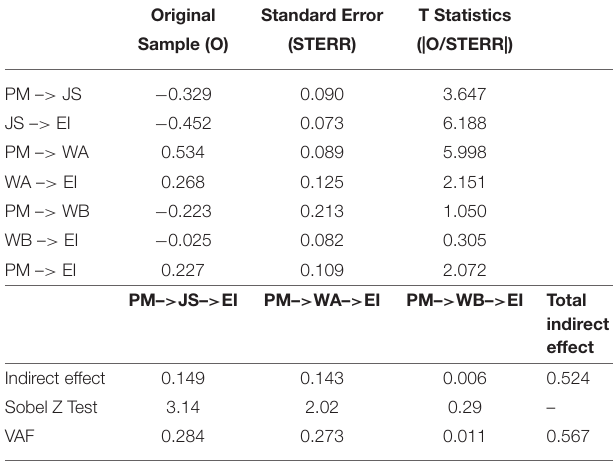
TABLE 8 | Test of mediation